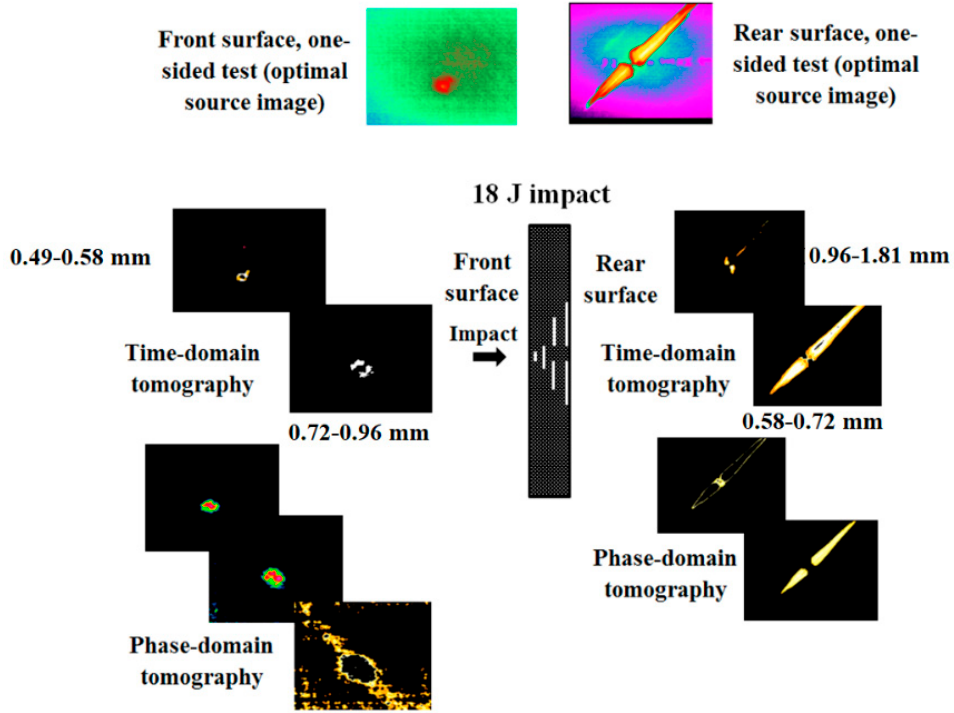
Figure 6. Time- and phase-domain thermal tomography of impact damage in 5 mm-thick CFRP sample (18 J impact energy).